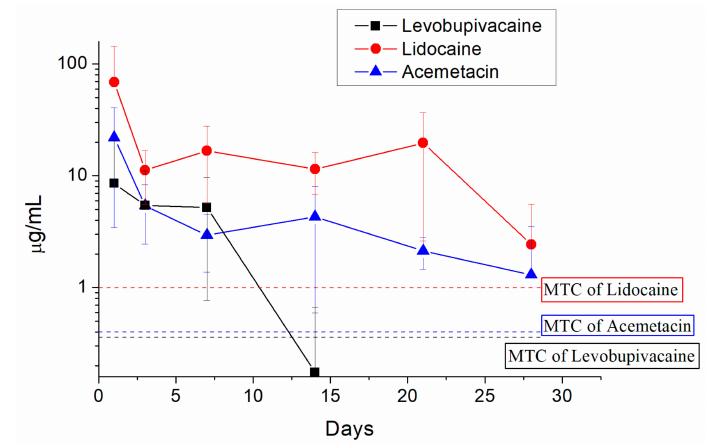
Figure 6. In vivo release curves of analgesics to the area surrounding the bone fracture site treated with analgesics-loaded microparticles. The levels of levobupivacaine (black squares), lidocaine (red circles), and acemetacin (blue triangles) were measured in the tissues 1, 3, 7, 14, 21, and 28 days after the treatment. The dashed lines indicate the minimum therapeutic concentrations (MTC) for each analgesic.